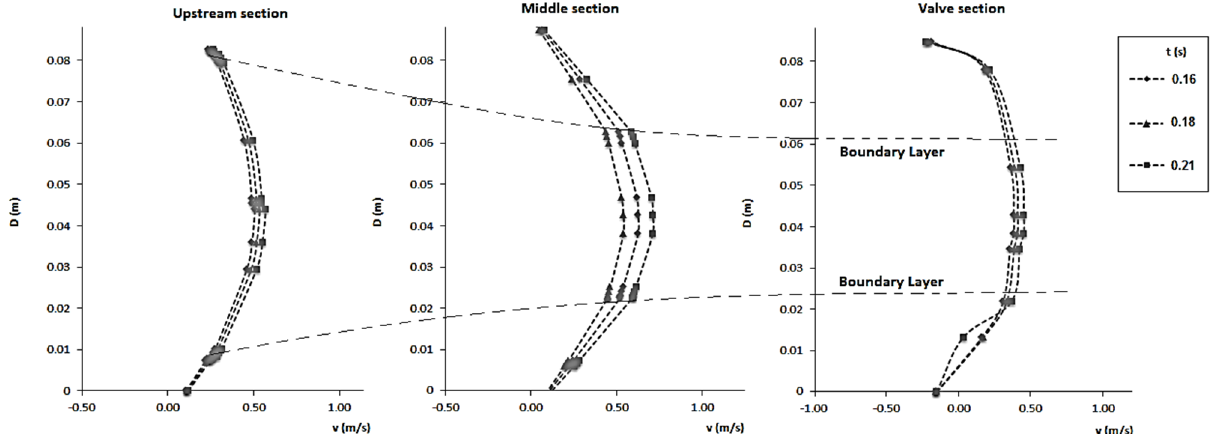
Figure 16. Velocity profile obtained at the valve section (location 1).